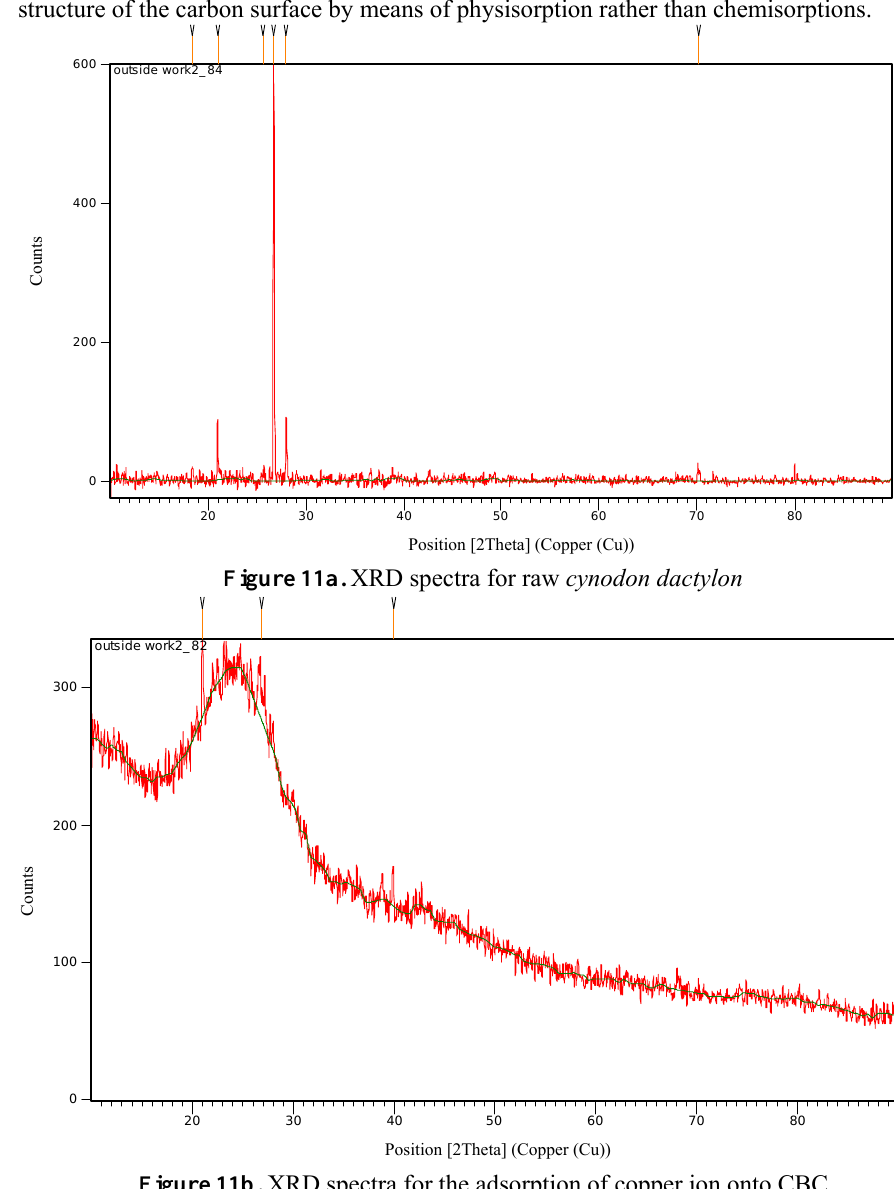
Figure 11b. XRD spectra for the adsorption of copper ion onto